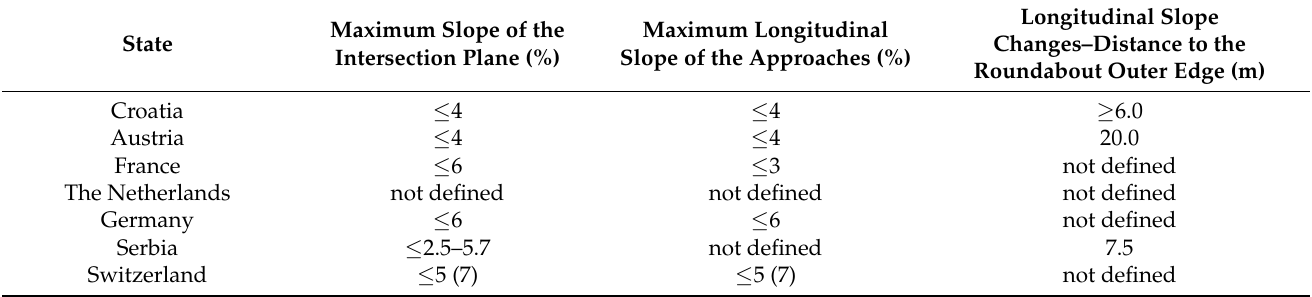
Table 8. Longitudinal slopes at roundabouts according to